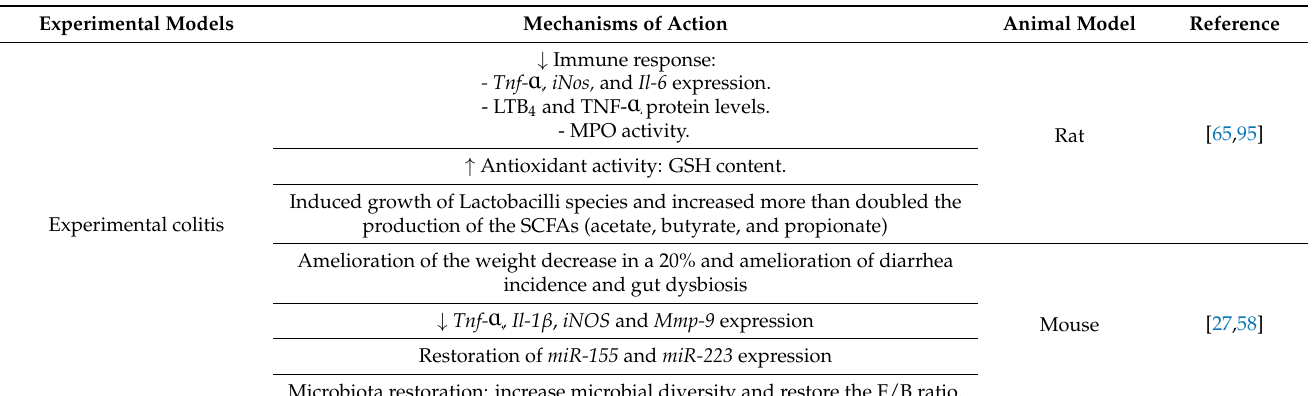
Table 4. Mechanisms of action of L. fermentum CECT5716 in animal models.